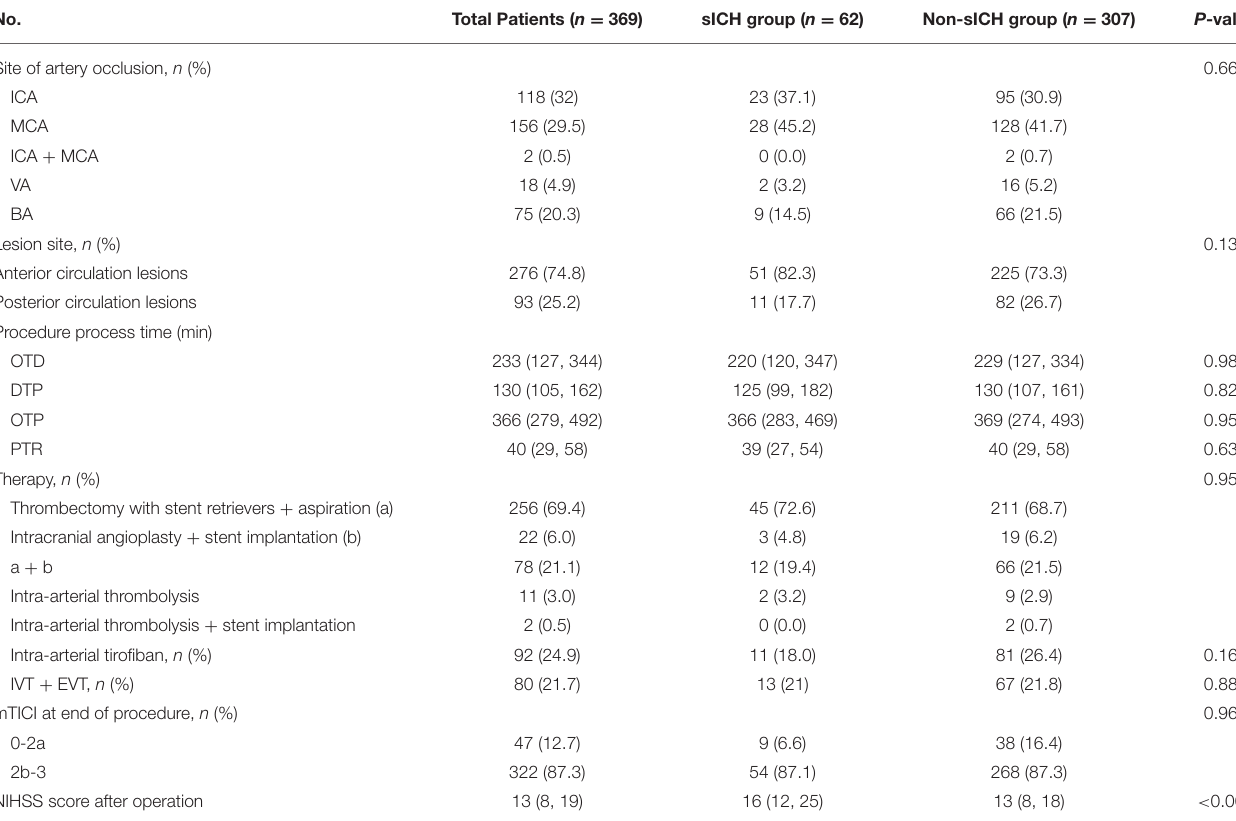
TABLE 2 | Procedural and treatment of patients with sICH and without sICH.